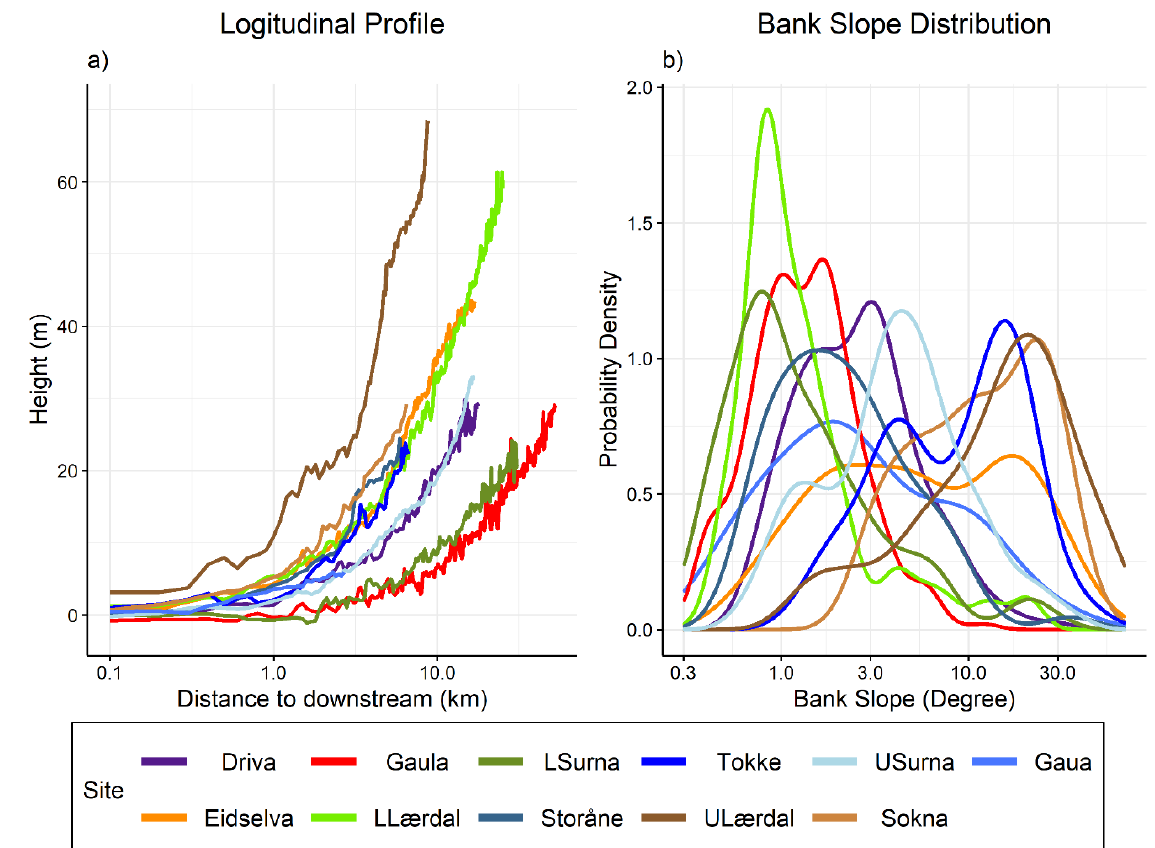
Figure 3. The longitudinal profile ( a ) and the bank slope distribution ( b ) for the 11 sites. U and L prior to Lærdal and Surna abbreviate Upper and Lower.